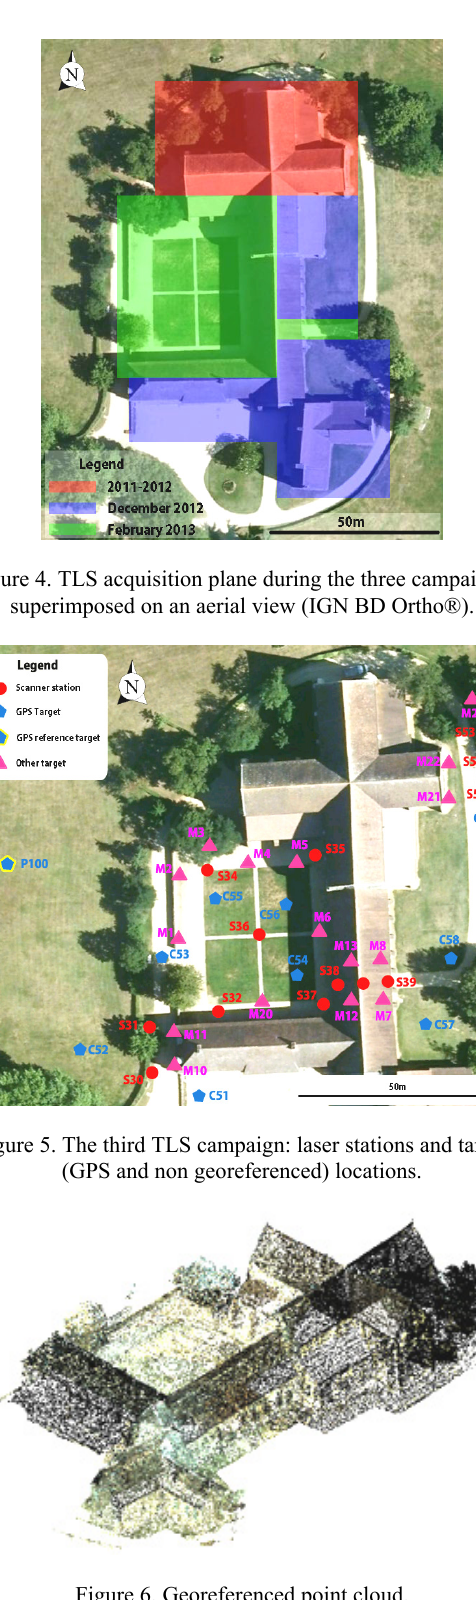
Figure 6. Georeferenced point